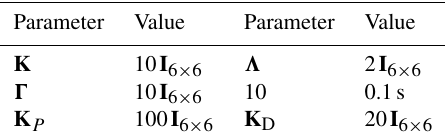
Table 3. Controller parameters for the virtual prototype experi- ments.